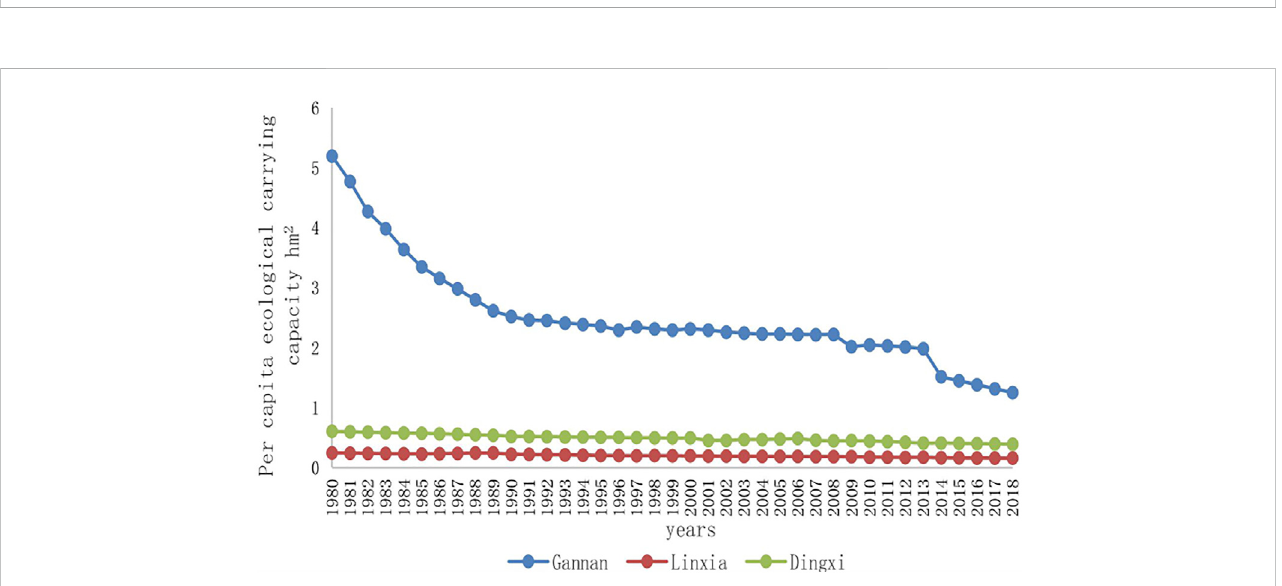
FIGURE 3 Comparison of per capita ecological carrying capacity (de fi cit) of the three places from 1980 to